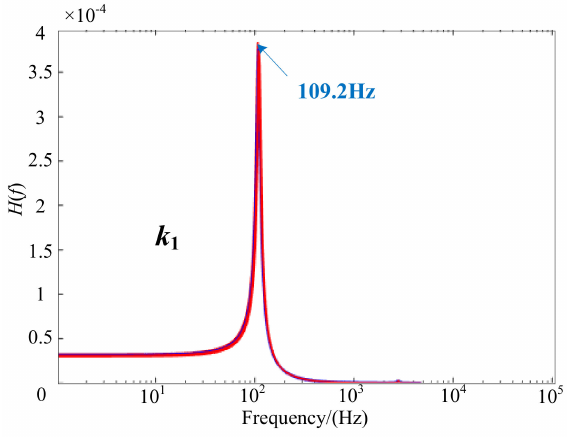
Figure 4. Effect of k 1 on the frequency response of the plastic